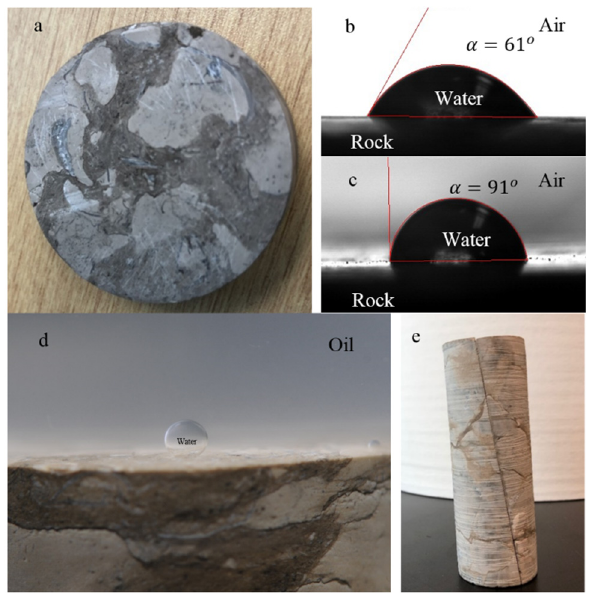
Figure 1. Pictures showing ( a ) intact Calumet carbonate, ( b , c ) measured contact angles of a water droplet at the dry surface of the rock revealing mixed wettability of the rock, ( d ) sessile drop test result showing the initial wettability of the carbonate rock to the oil phase, and ( e ) artificially fractured specimens.